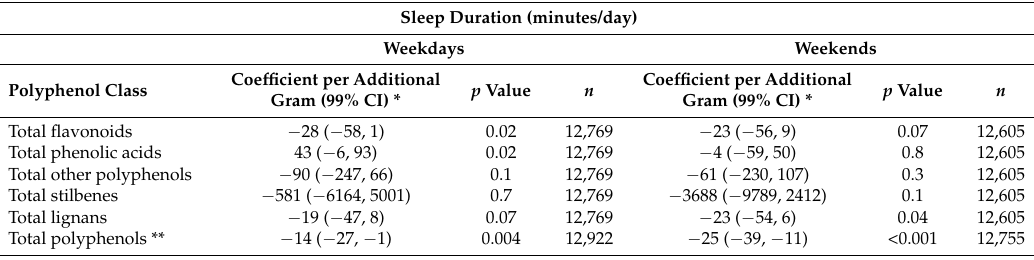
Table A4. Prospective associations between polyphenol content from fruit and vegetable intakes and sleep duration for women from the UKWCS based on weekdays and